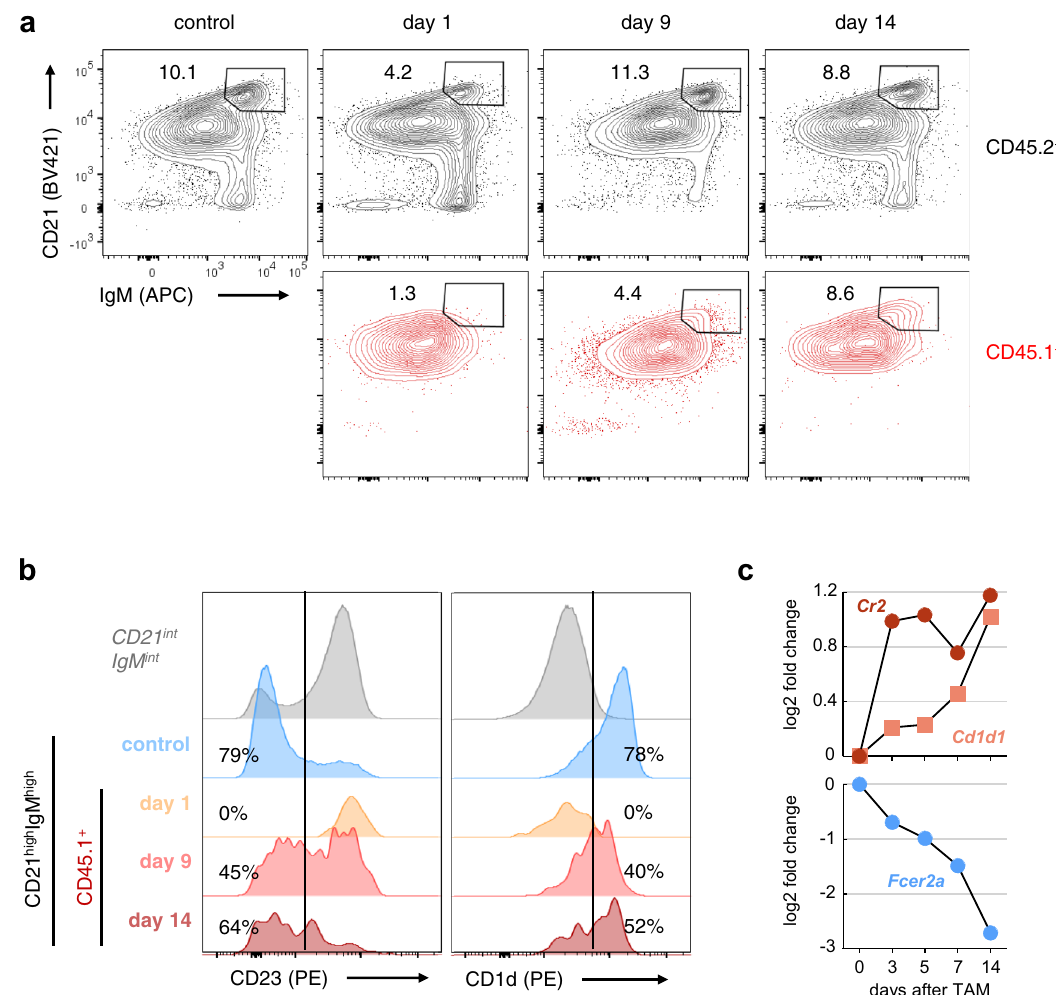
Fig. 7 FoB cells differentiate to MZB B cells via an MZP cell stage. a Representative fl ow cytometric analysis of CD45.2 + recipient and CD45.1 + recovered donor cells for MZB precursor (MZP) and mature MZB cells at the indicated time points after adoptive transfer. Cells were gated for B220 + B cells, followed by identi fi cation of CD21 high IgM high cells, comprising MZP and mature MZB cells. Plots are representative for n = 4 (d1), n = 4 (d4), n = 2 (d9), n = 7 (d14) independent experiments. b Colored histograms show downstream gating of CD21 high IgM high for CD23 and CD1d levels to separate CD23 low CD1d high MZB from CD23 + CD1d med MZP cells. The gray histograms represent CD23 and CD1d expression from the CD21 int IgM int FoB population. c Median fold changes in RNA levels of Cr2 (CD21), Cd1d (CD1d) and Fcer2a (CD23) in hCD2 + versus hCD2 − cells over time after induction of Notch2IC- expression (experiment shown in Fig.